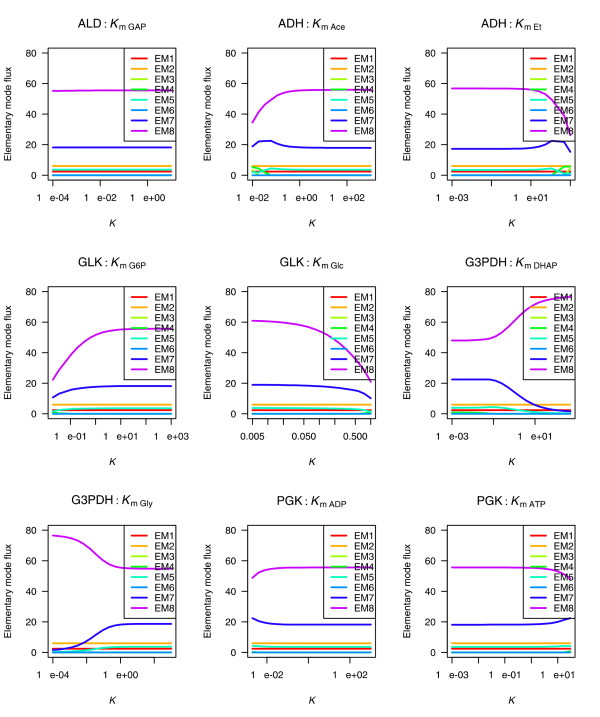
Effects of kinetic parameters on elementary mode fluxes. Effects of single kinetic parameters on elementary mode fluxes. In each example, the variable parameter is indicated at the top of the graph, and all other parameters were kept at their reference values given in Table 2. Horizontal axes use logarithmic scales.